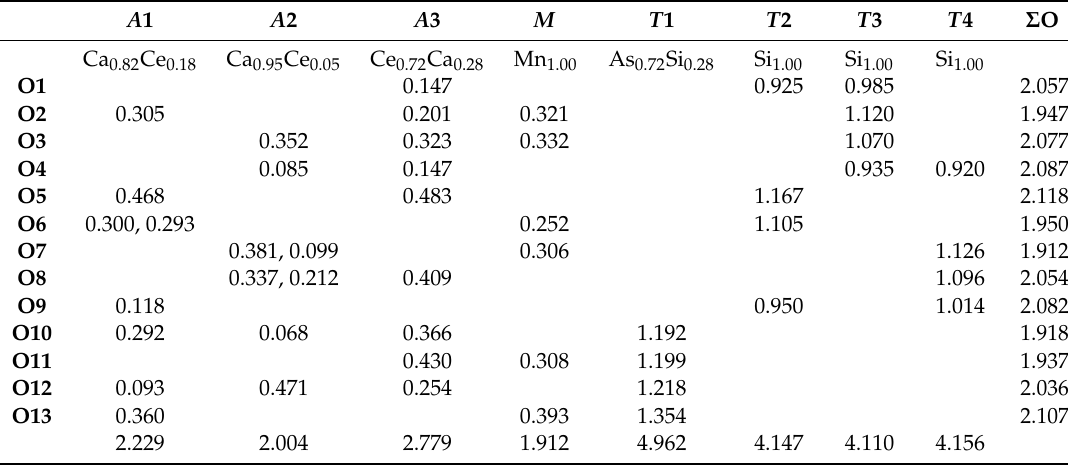
Table 8. Calculated bond-valence sums (BVS, in valence unit, i.e., v.u.).